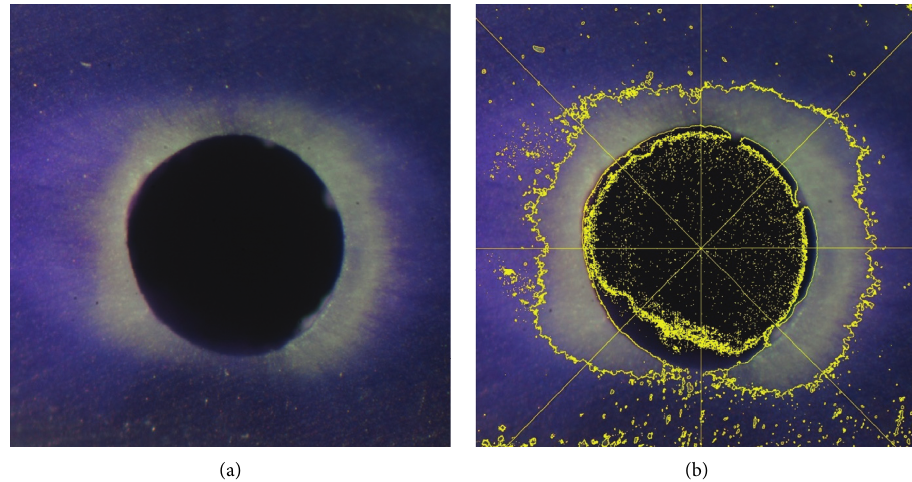
Figure 1: (a) A bleached crystal violet image of the EDDY40 group under a stereomicroscope (original magnification, 40x). (b) Determining the bleached depth by ImageJ